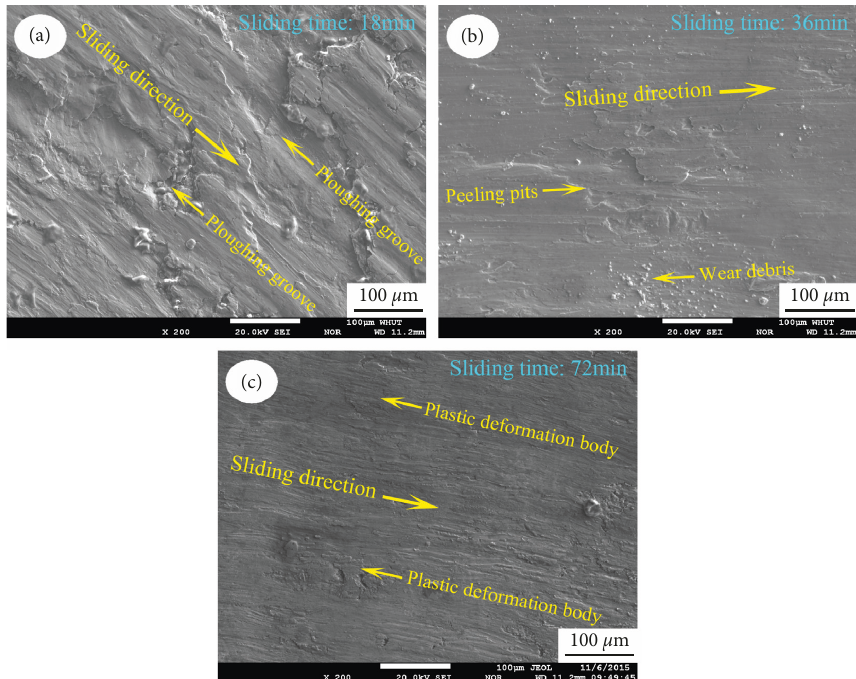
Figure 7: Typical EPMA morphology of wear scars of the TASC sliding against the fixed Si